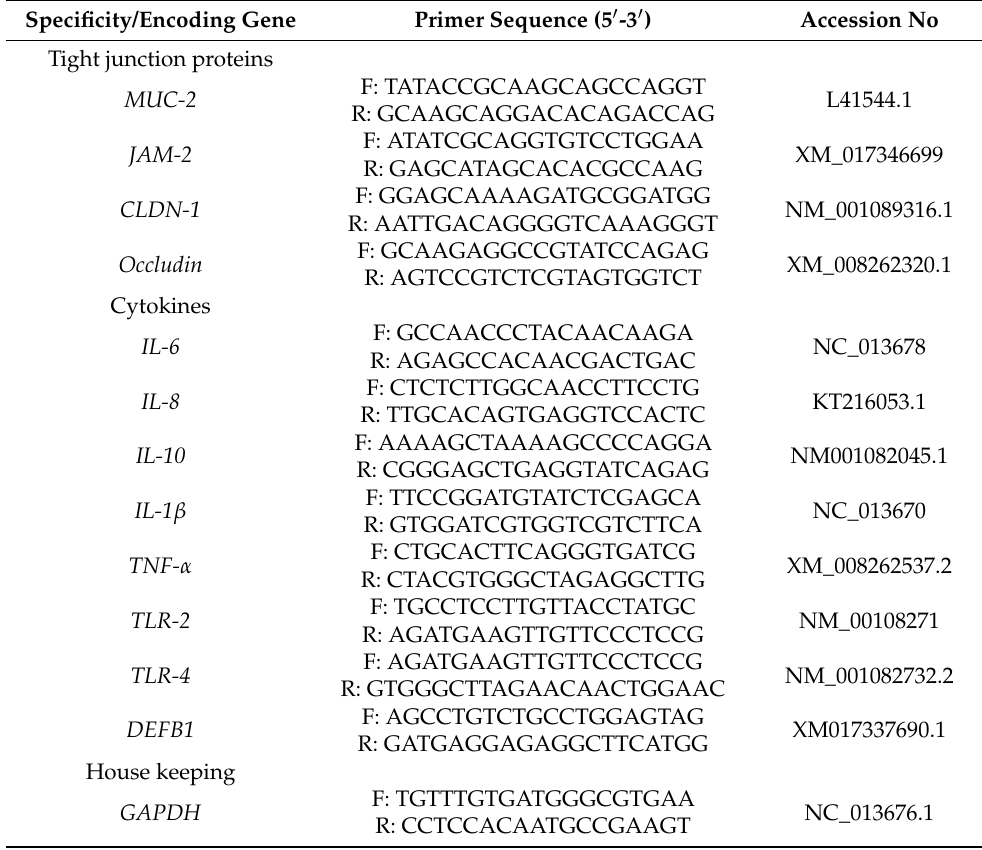
Table 2. Primer sequences utilized for qRT-PCR